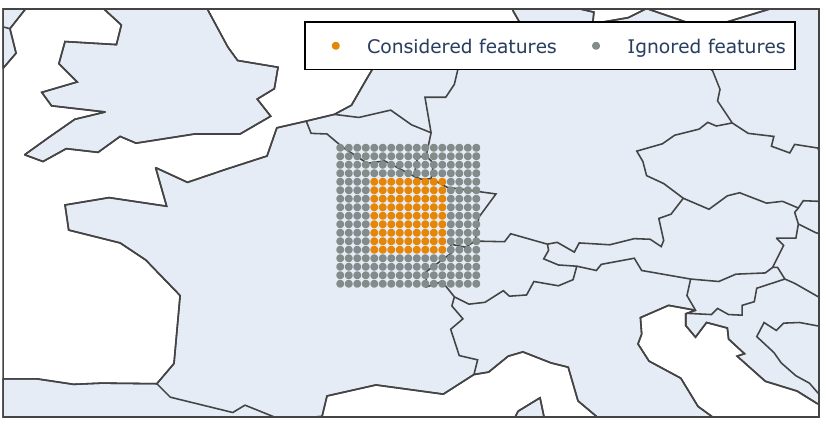
Figure 7. An example of a 9 × 9 square grid centered around the wind farm. Features belonging to the selected grid are considered as input features for the model, while the others are ignored.